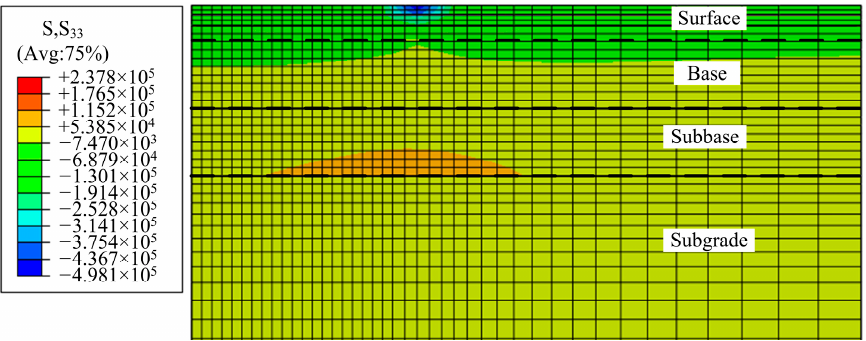
Figure 11. Horizontal stress in middle section when load moves over it at initial speed of 10 km/h.